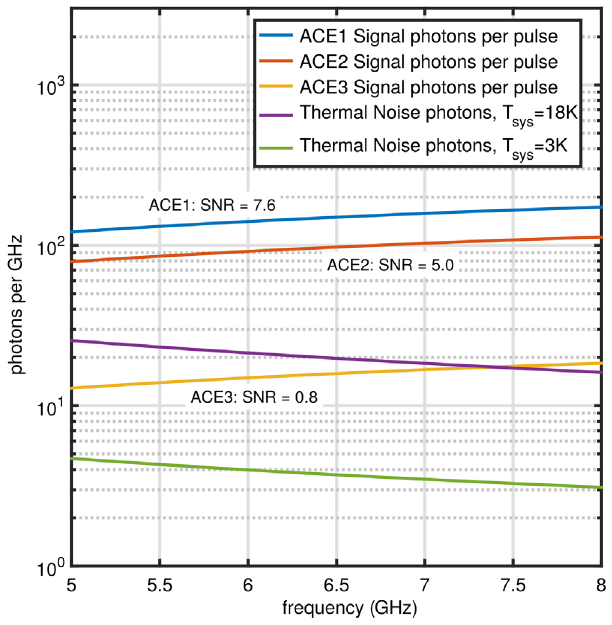
FIG. 7. Prediction for our experimental parameters from Tamm theory, for the case of showers from bunches of 100 electrons of 12.16 GeV energy. Two cases of thermal noise threshold ¼ 18 K, corresponding to our are shown for comparison, T sys ¼ 3 K for a liquid- measured data, and a projection for T sys helium cooled system.